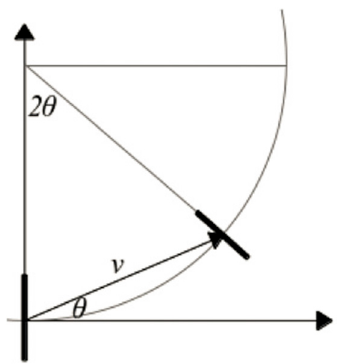
Figure 3. Direction of a stick vote pointing to the center of the osculating circle [37] Figure 5. Direction of a stick vote pointing to the center of the osculating circle